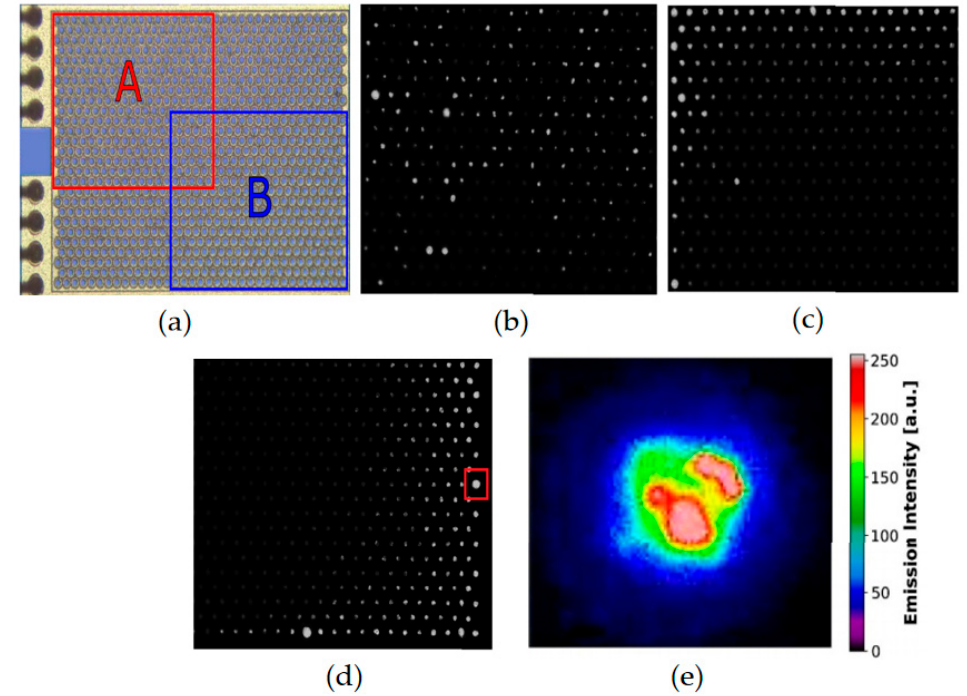
Figure 12. ( a ) High-power 2D-VCSEL array consisting of 932 emitters. ( b ) Reverse-bias EMMI image of region A of the VCSEL array before stress; ( c ) reverse-bias EMMI image of region A of the VCSEL array after stress; ( d ) reverse-bias EMMI image of region B in the VCSEL array after stress; and ( e ) colorized close-up of the marked emitter in ( d ) [70]. Reprinted with permission from ref. [70] © IOP Publishing. Copyright 2021 Measurement Science and Technology.